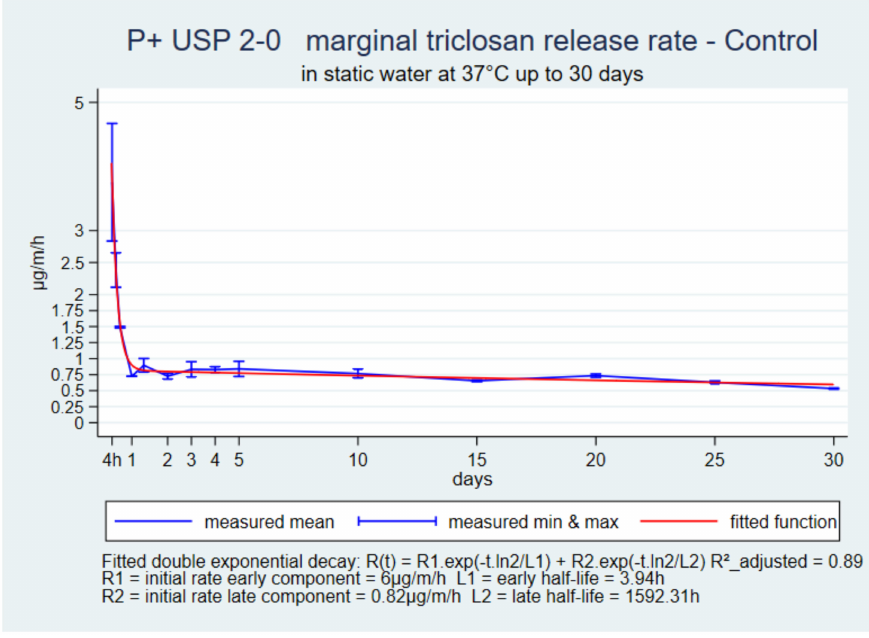
Figure 2. P+ USP 2-0, marginal release rate in static water up to 30 days.